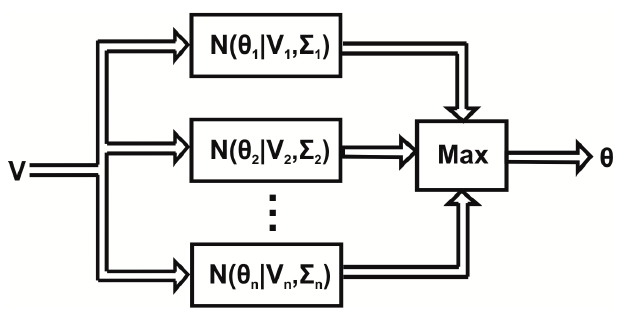
Figure 4. GMM implementation.